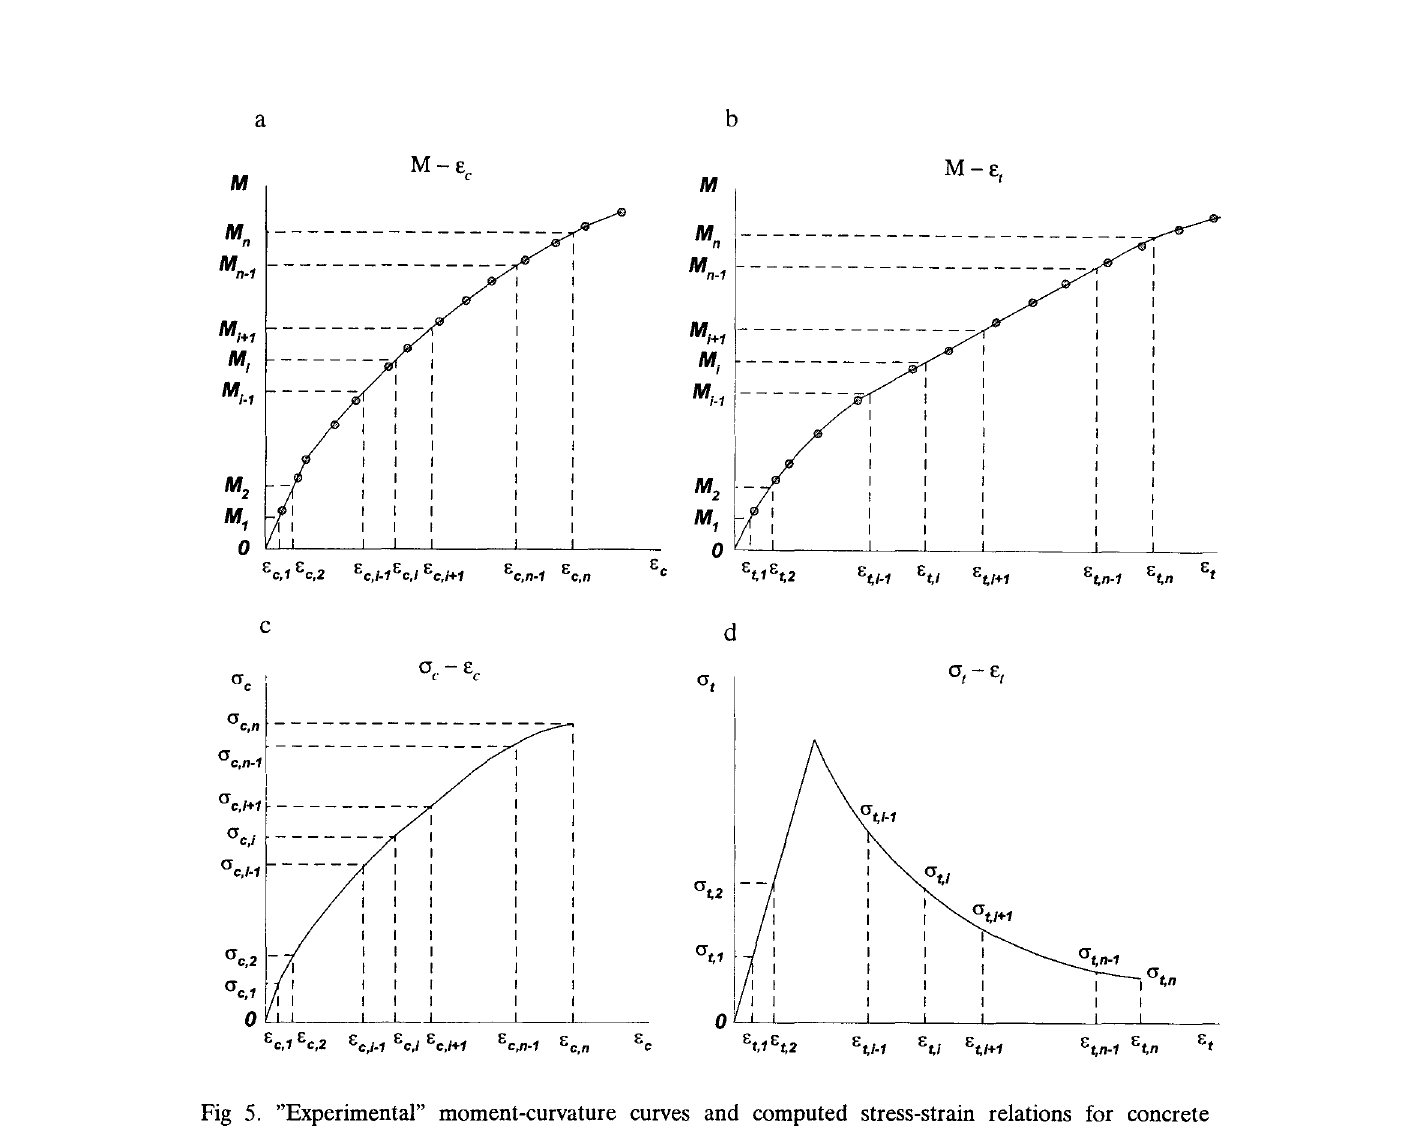
Fig 5. "Experimental" moment-curvature curves